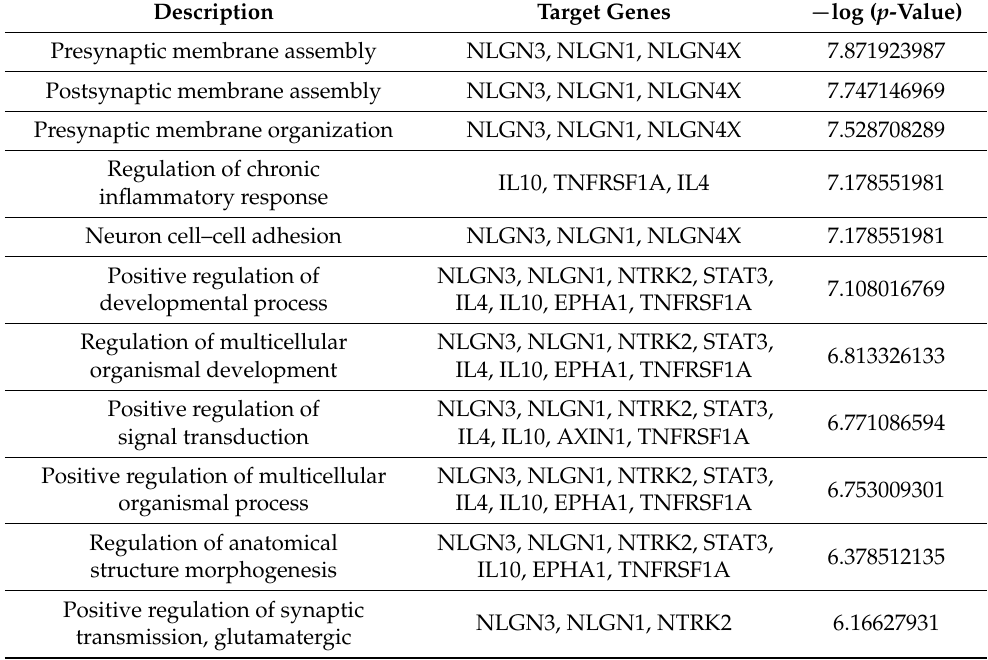
Table 2. Biological process enrichment results for predicted novel genes of multiple sclerosis (MS) and obsessive-compulsive disorder (OCD).